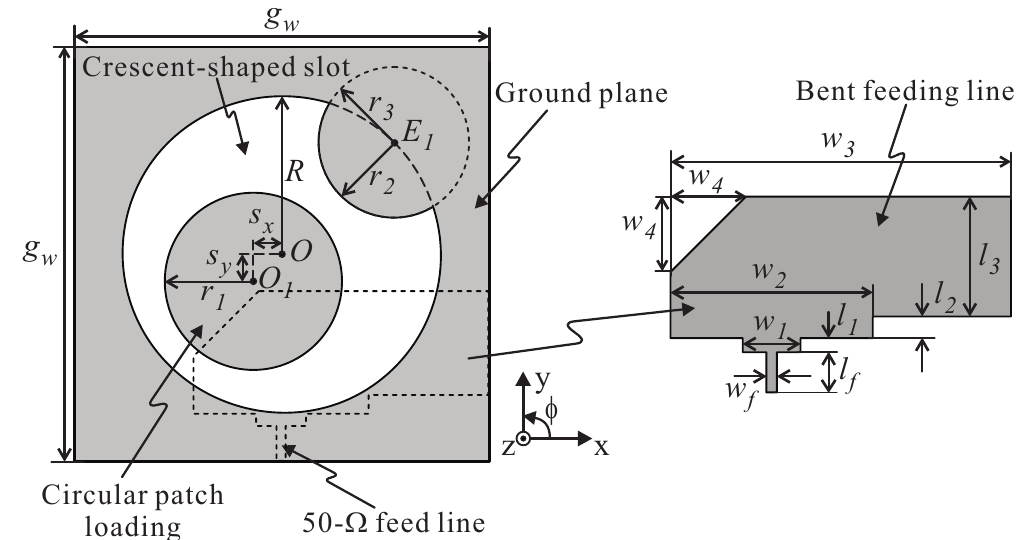
Figure 1. Proposed antenna configuration.